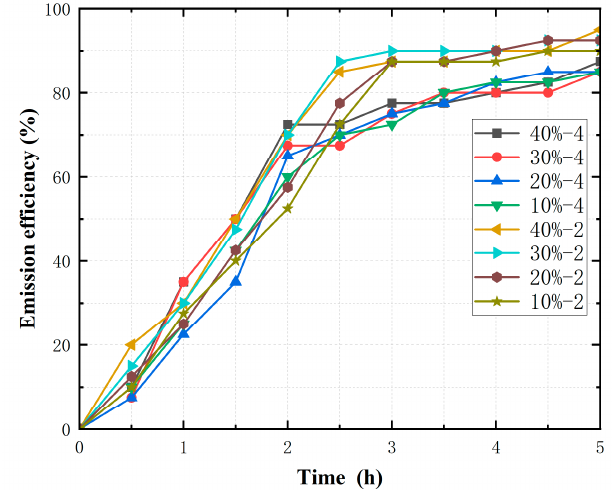
Figure 22. Emission effect curves under different inlet pipes.